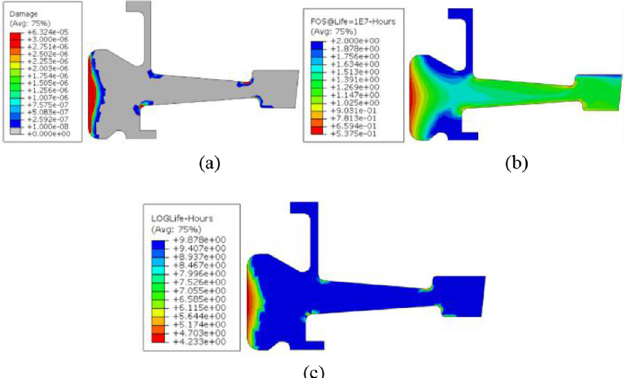
Fig. 10. Results of fatigue damage, FOS factor, and logarithmic fatigue life of GH4169 disc at maximum speed: (a) fatigue damage distribution, (b) FOS factor distribution nephogram, and (c) logarithmic fatigue life distribution nephogram.